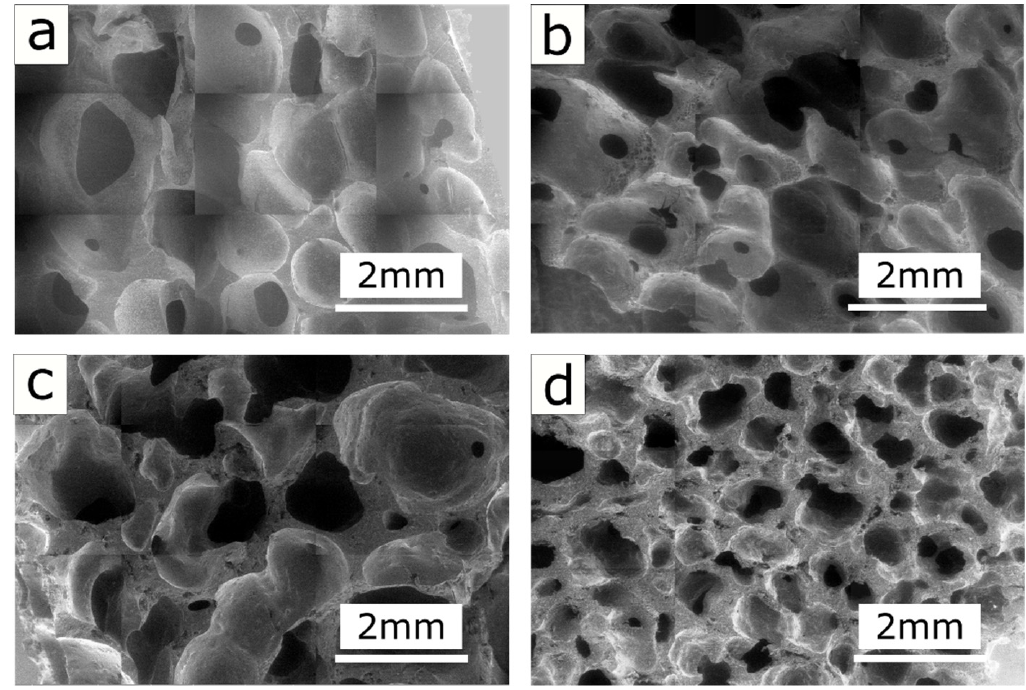
Figure 1. Representative SEM images of 0-EGF ( a ), 3-EGF ( b ), 5-EGF ( c ), 7-EGF ( d ).